Question: Sum up the contents of this chart in one sentence.
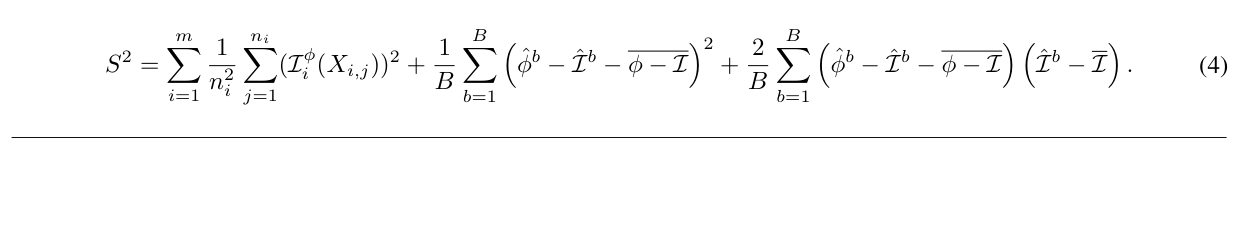
Answer: We consider modeling the relationship between resampled distribution and simulation output as nuisance estimation in orthogonal statistical learning. In Orthogonal Bootstrap, we use linear modeling for the nuisance estimation and only focus on the simulation of the orthogonal part (i.e. the residual of linear modeling) to reduce the simulation error.